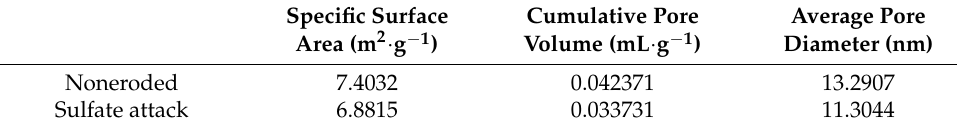
Figure 12. Pore diameter distribution of C 3 S-C 3 A paste under sulfate attack. Table 6. Pore characterization of C 3 S-C 3 A paste under sulfate attack.